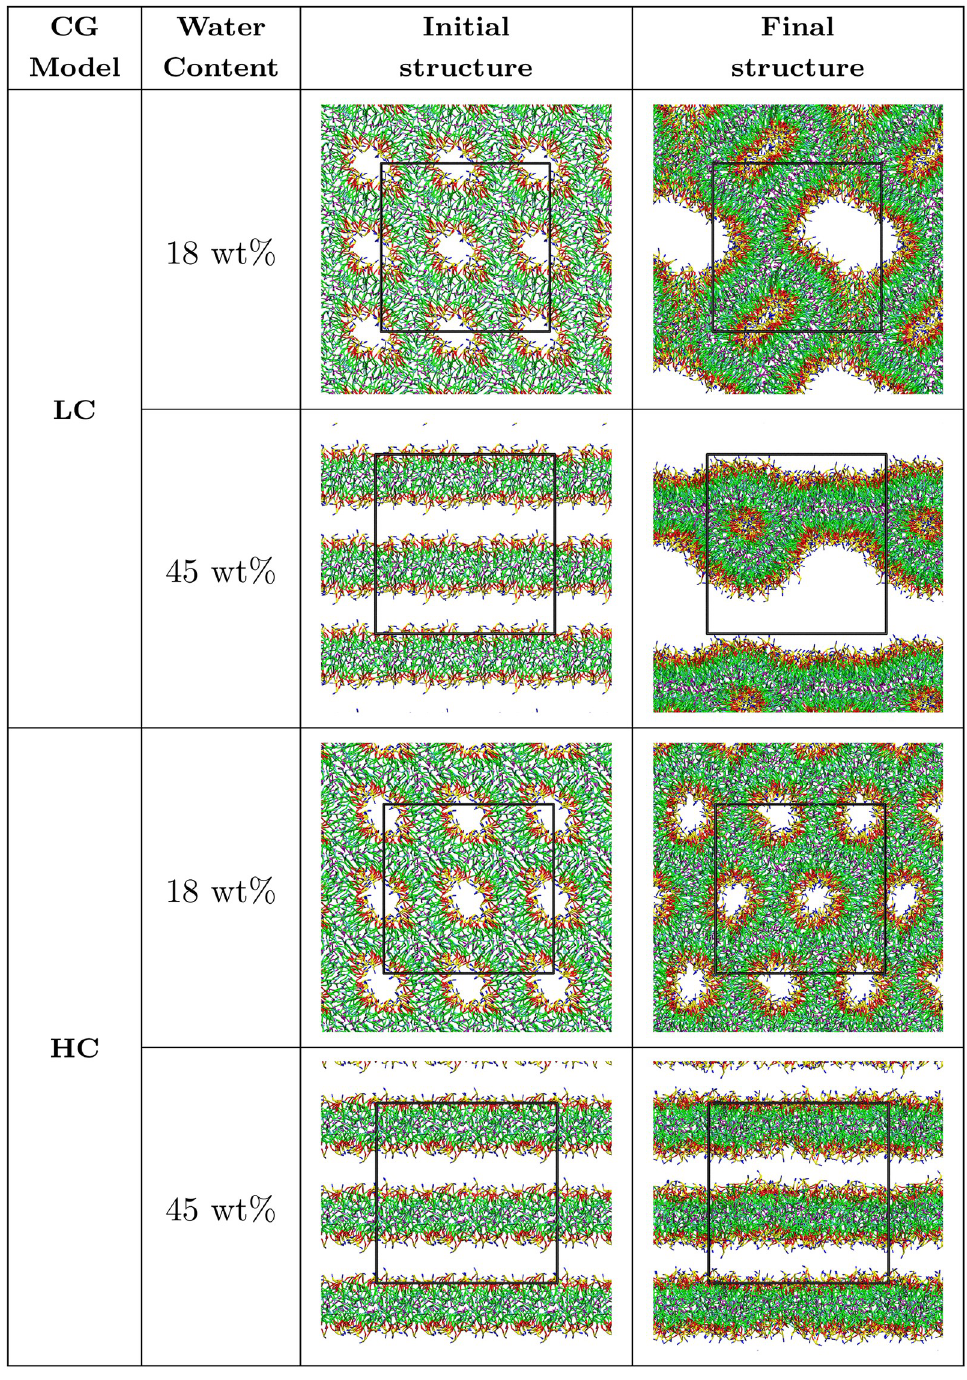
Fig 5. Initial and final snapshots of the 40 ns CG simulations of 480 lipid molecules at two different water contents by using potential functions of the LC and HC models.